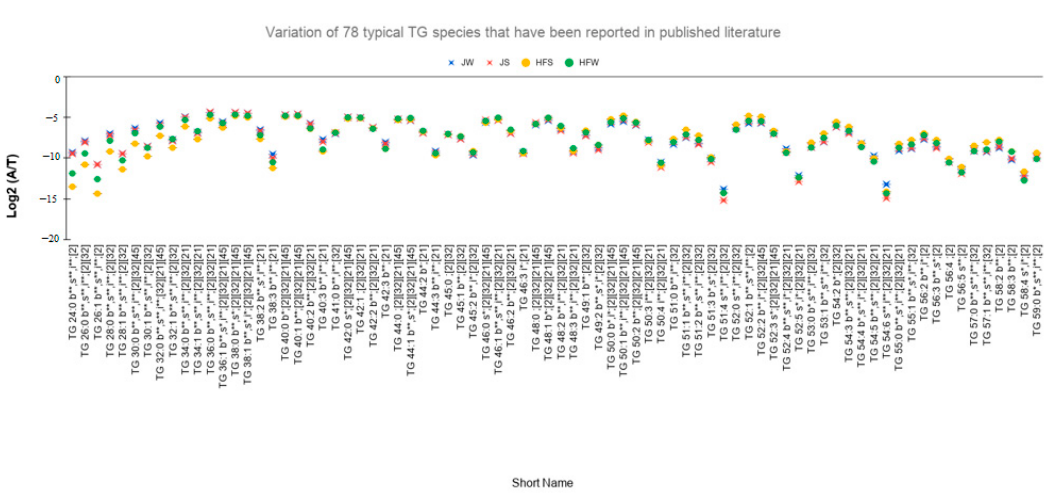
Figure 4. Comparison of TG lipids. Interbreed variation of TG compositions that have been reported in the published literature ( n = 78, i*,** = 49, b*,** = 61, s*,** = 44, bsi*,** = 29, where n is the total number of TG species, b/s/i/bsi with suffix *,** denotes the number of TG species for which the effect of breed/season/interaction/each main effect as well as the interaction is significant).